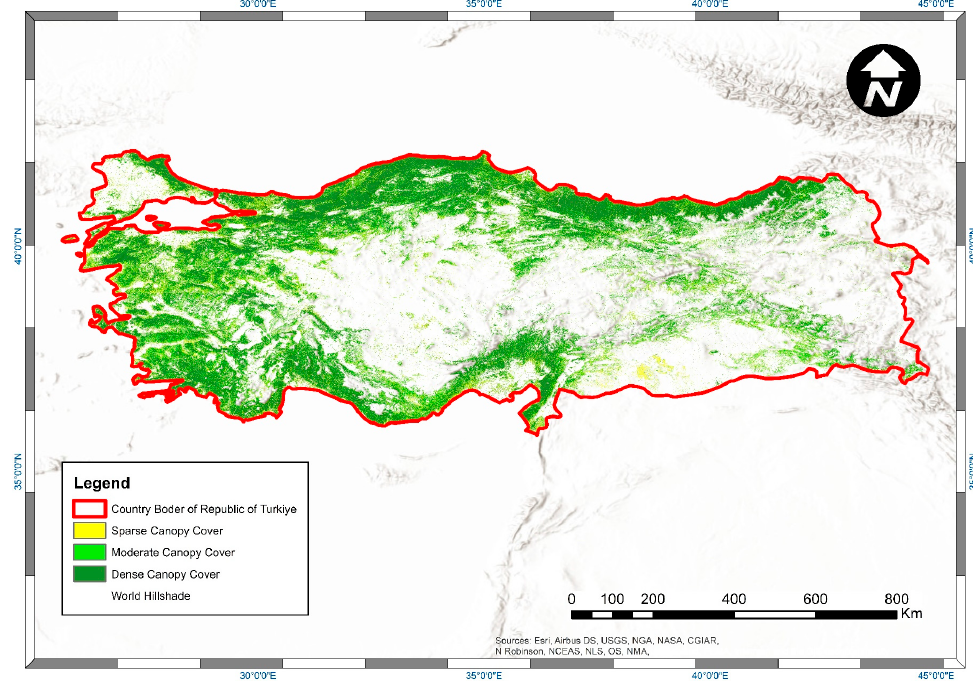
Figure 6. Canopy cover map of Türkiye for the year 2021 derived by ATL08 segments and CCEM (ESRI World Hillshade Basemap). Table 4. Visual accuracy assessment result of CCEM-derived canopy cover map (predicted canopy cover map). The red font in the results indicates the number of interpretation grids that correctly estimated canopy cover class in CCEM derived canopy cover map. The blue font in the results indi- cates the number of grids that correctly estimated canopy cover class in CCEM derived canopy cover map, but failed in land cover.